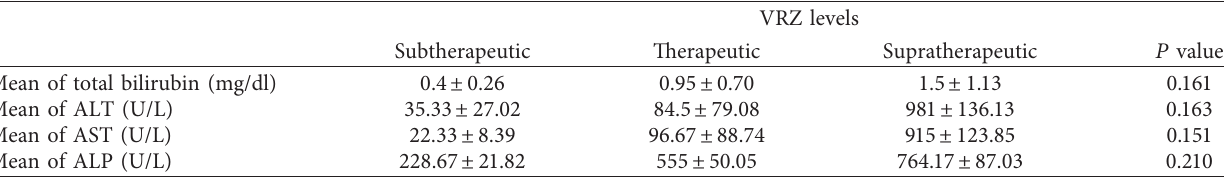
Table 3: The results of the liver function test according to voriconazole plasma